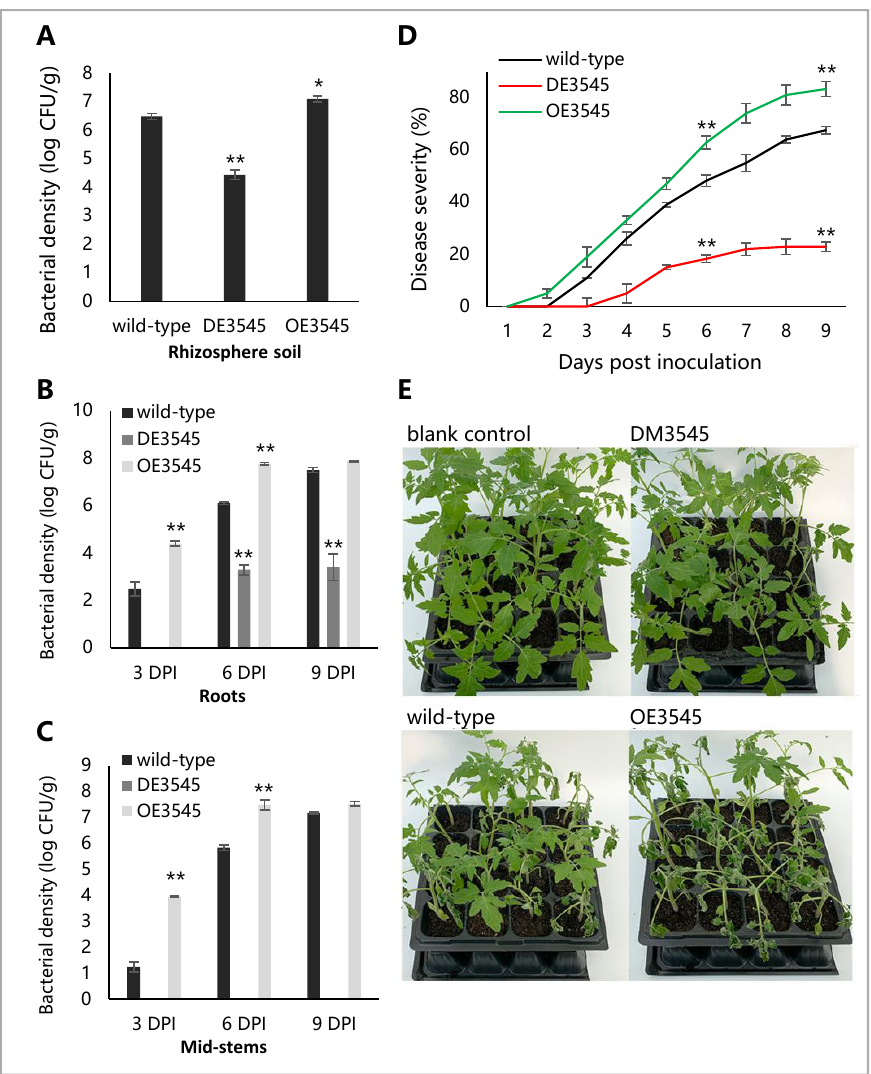
Figure 3. Determining the bacterial population in the soil and plants by soil-soak inoculation method. The figure marked with asterisks, indicating p < 0.01 (**) or p < 0.05 (*), was compared with the wild-type and statistically analyzed by ANOVA based on Fisher’s LSD test. The bacterial population (CFU/g of fresh weight) was log-transformed. ( A ) Amount of bacterial CFUs per gram of soil tissue at 1 DPI. ( B ) Amount of bacterial colony forming units per gram of roots tissue at 3, 6 and 9 DPI. ( C ) The amount of bacterial CFUs per gram of mid-stems tissue at 3, 6 and 9 DPI. No bacterial colony of DE3545 was detected. ( D ) Disease severity of three strains at 1–9 DPI. ( E ) Growth of R. solanacearum -inoculated tomato plants at 9 DPI.